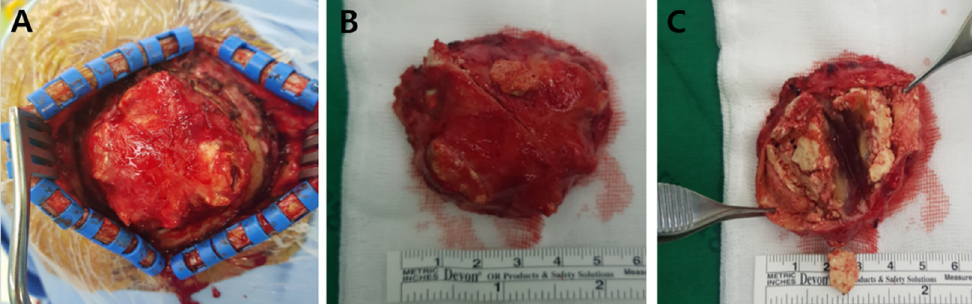
Figure 4. Gross specimen. A 5.0 × 4.5 × 3.0 cm sized, well-defined mass is seen in the right parietal region ( A ). The mass is surrounded by fibrous cap and several ivory-colored bone tissues ( B ). It contains degenerate jelly-like materials and multi-stage hemorrhagic contents ( C ).